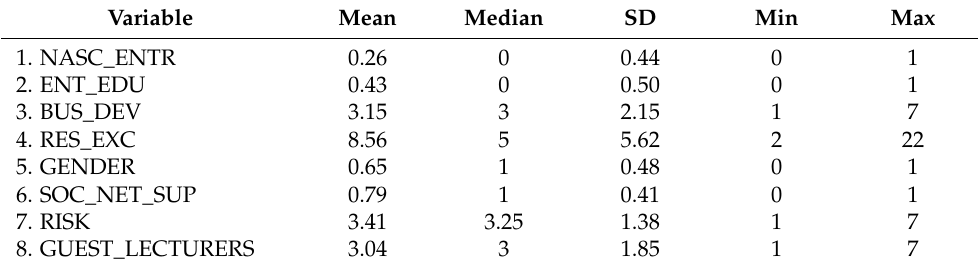
Table 4. Descriptive statistics of the variables used in the